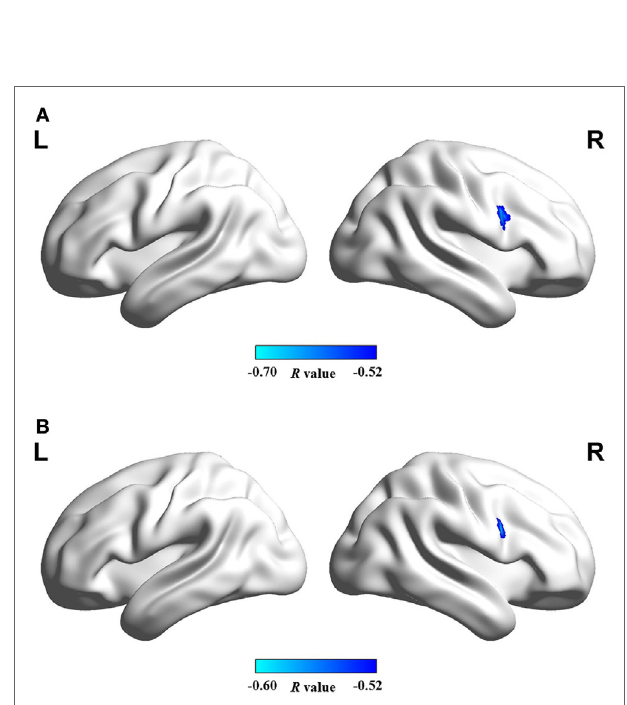
FigUre 5 | Brain regions in which functional connectivity with ECN RDLPFC seed was significantly correlated with the cirrhotic patients’ performances in Stroop task, i.e., (a) ontime and (B) ontime minus offtime. Abbreviations: ECN, executive control network; RDLPFC, right dorsolateral prefrontal cortex.